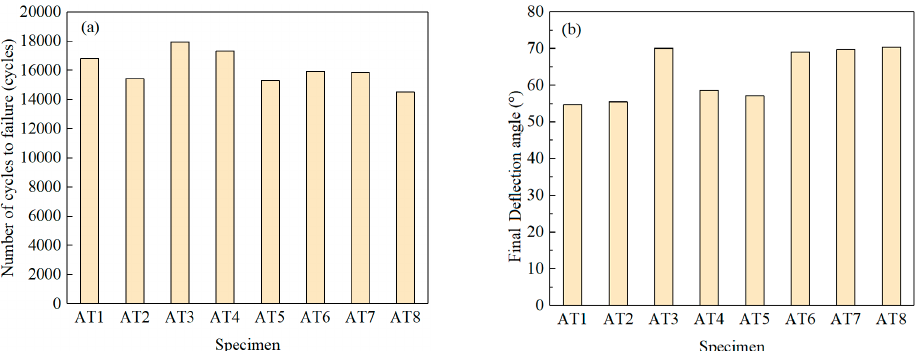
Figure 4. Test results of low-cycle fatigue under axial-torsion loading: ( a ) Fatigue life and ( b ) Final deflection angle (AT stands for axial-torsional test).